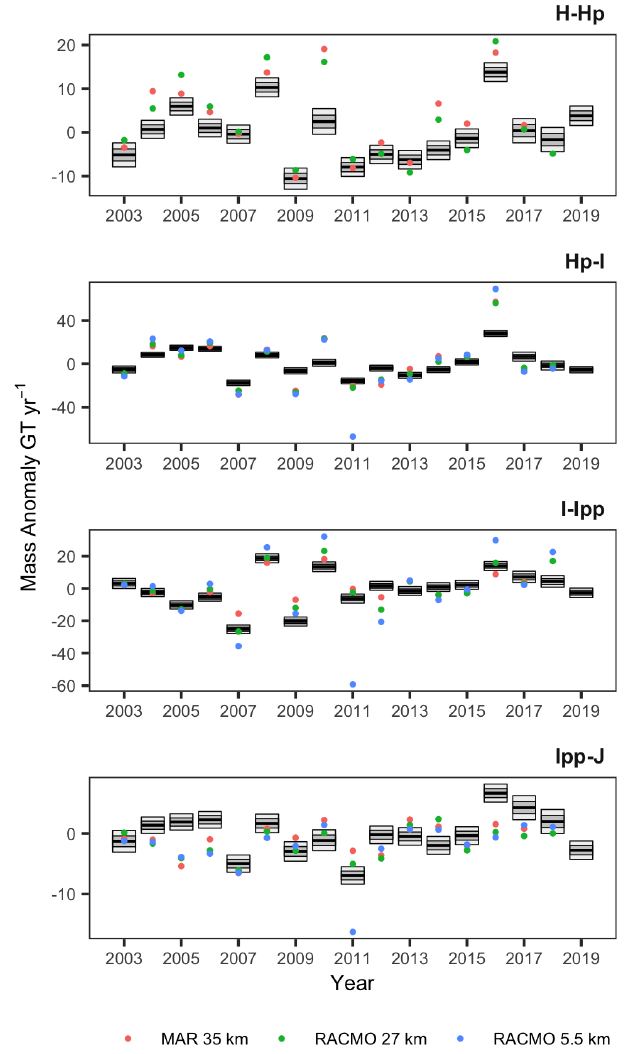
Figure 7. Comparison of BHM SMB posterior mass trends with RCM output for each year of the study, at the individual basin scale. Black lines represent BHM posterior mean, with dark and light grey boxes representing the 1 σ and 2 σ uncertainty, respectively, on the latent process. Points represent the output from different RCMs (Agosta et al., 2019; van Wessem et al., 2016, 2018). Note that spa- tial coverage of the RACMO2.3p2 5.5km model does encompass the full area of basin H-Hp (Abbot sector) and is therefore excluded from analysis in this region. Methodology used for dataset compar- ison is outlined in Sect.